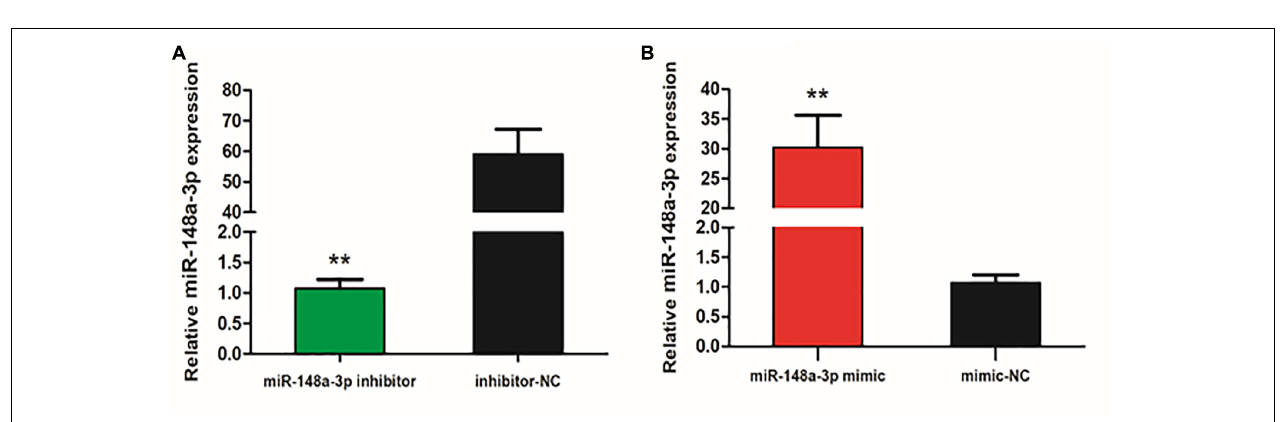
FIGURE 1 | Expression of miR-148a-3p in SMSCs. (A) Expression of miR-148a-3p in tissues of chickens. (B) Expression of miR-148a-3p in chest muscle during embryo development of ROSS 308 (broiler) and White Leghorn (layer). (C) Expression profile over time of miR-148a-3p from 1 to 5 days of satellite cell culturing. (D) Morphological changes in chicken skeletal muscle satellite cells after 1, 3, and 5 days.